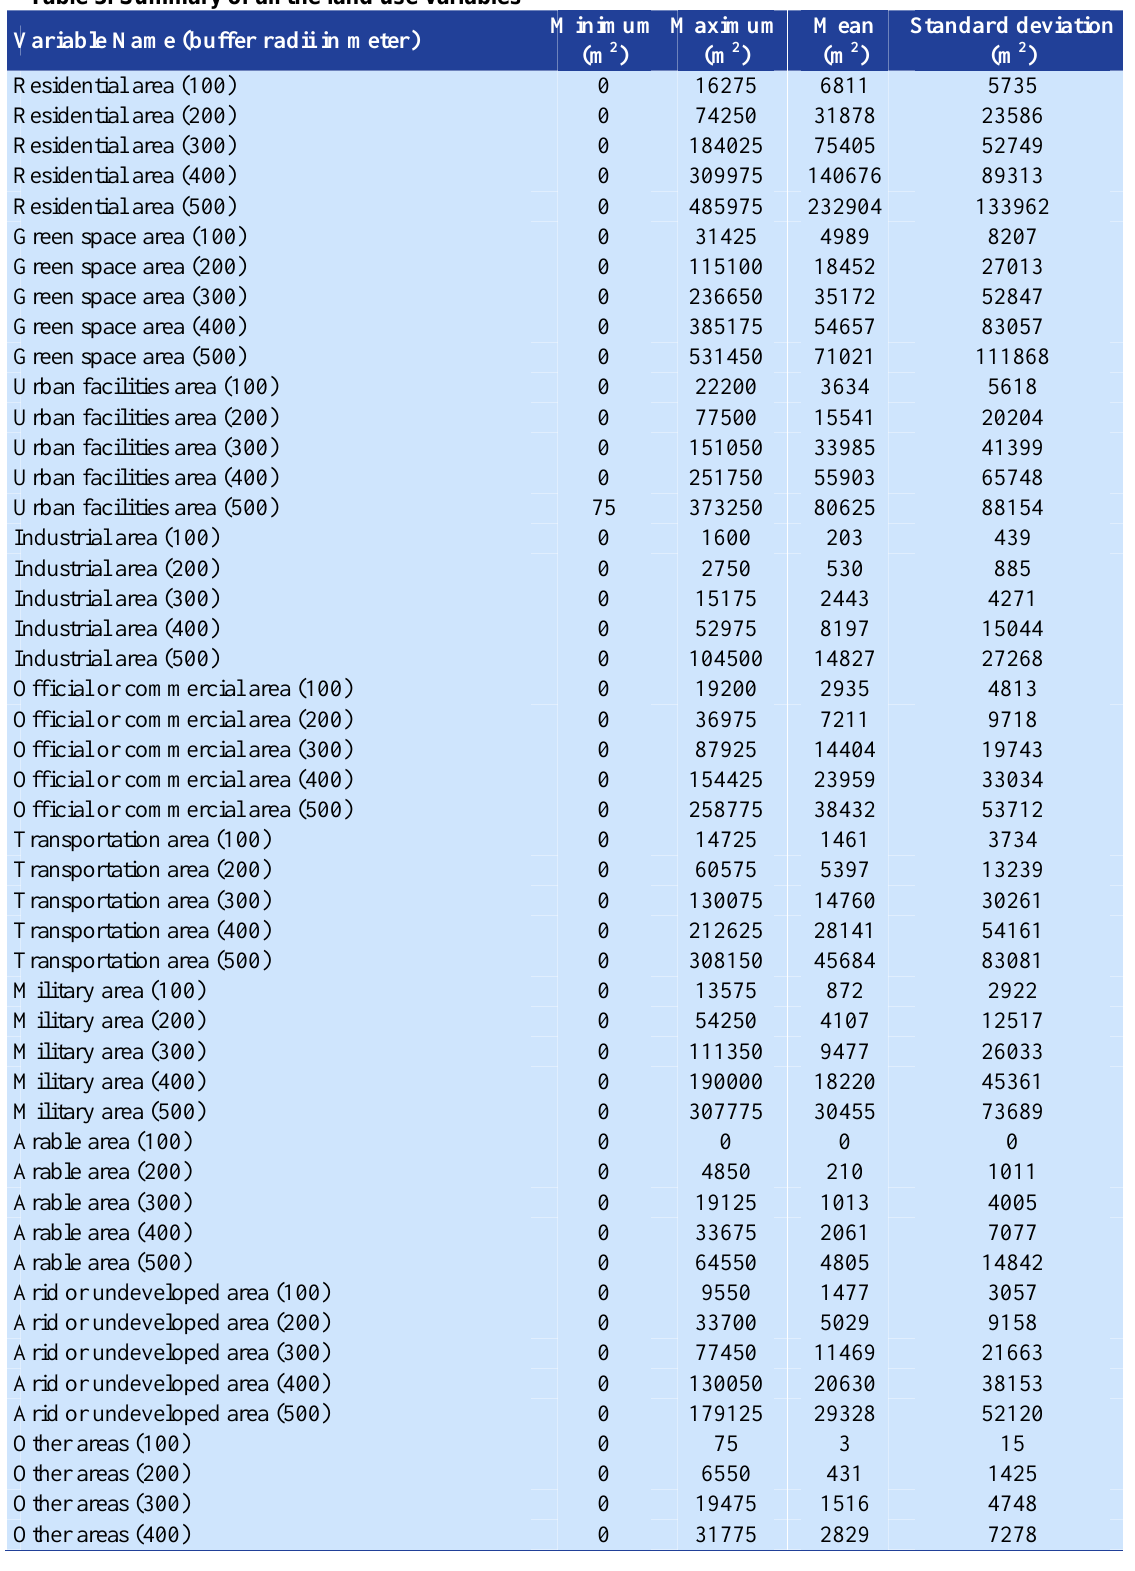
Table 3. Summary of all the land use